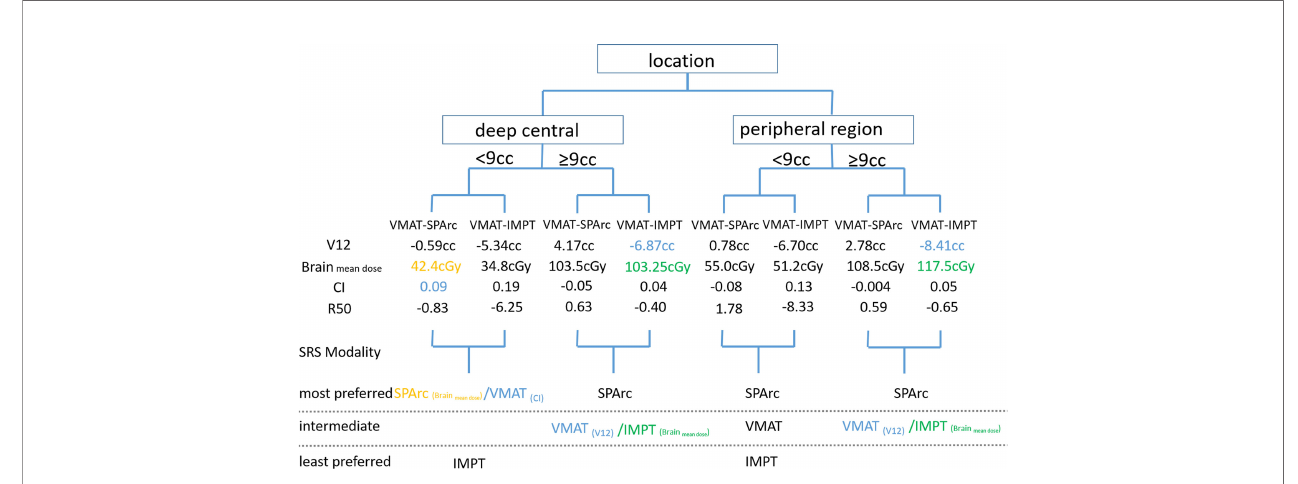
FIGURE 5 | Treatment decision tree and model to predict the optimal treatment modality based on tumor size and location. SPArc would be the optimal choice in most of the target size or location except deep centrally located target. This would be the physician ’ s clinical decision to favor the CI or brain mean dose